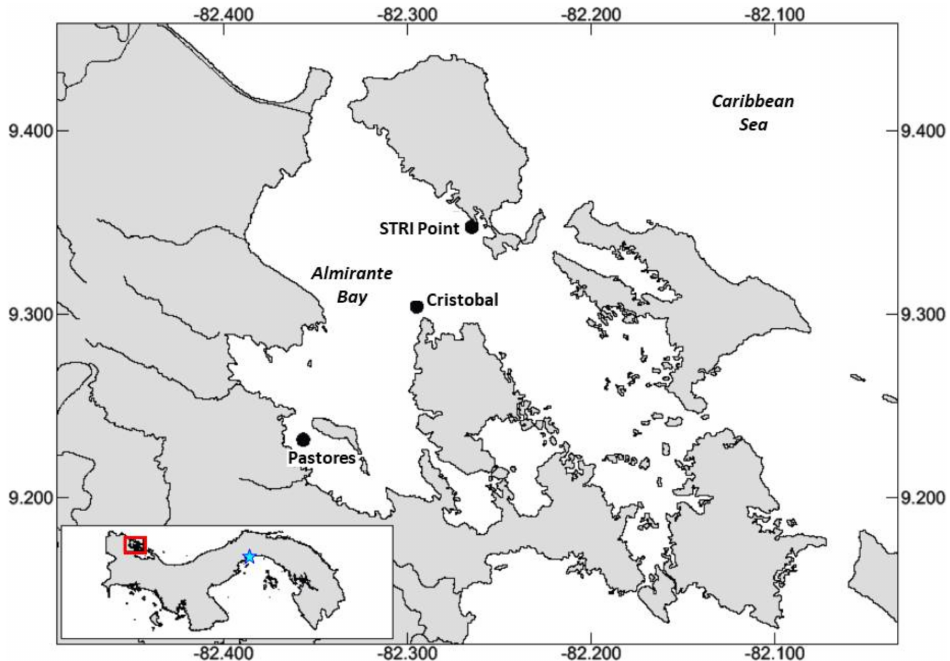
Figure 1. Map of sampling sites (black circles) in Almirante Bay, Bocas del Toro, Panama. Inset map shows location of Almirante Bay (red box) within Panama. Panama City is shown as a blue star. Horizontal axis indicates latitude, and vertical axis indicates longitude (decimal